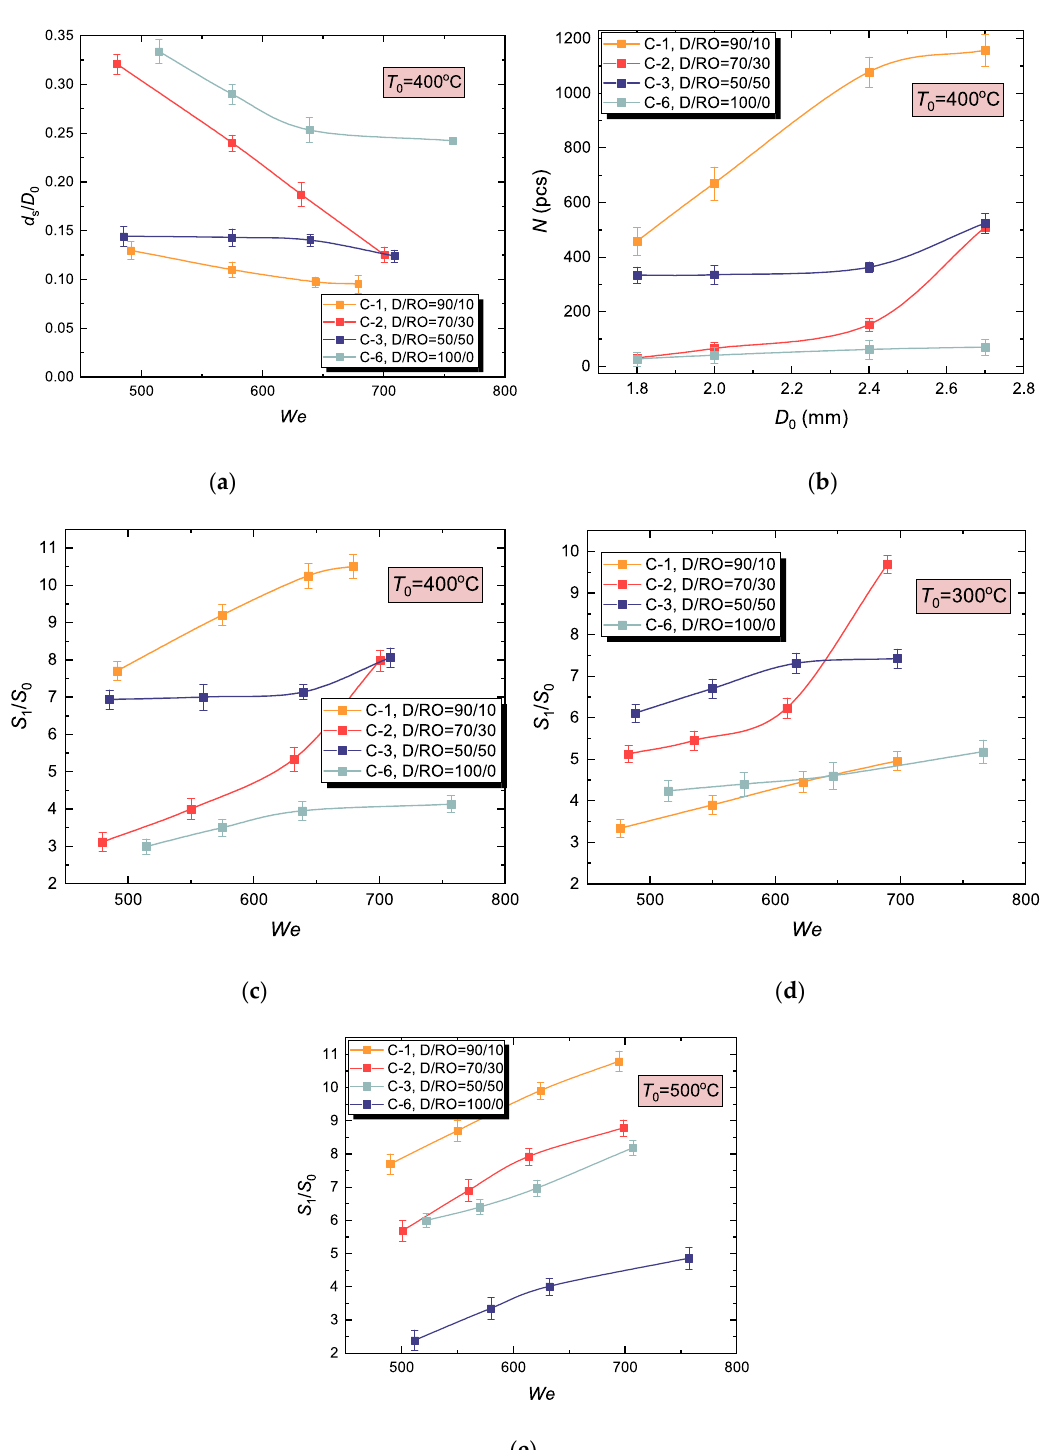
Figure 8. Effect of FAME of rapeseed oil (RO) added to the hydrocarbon component of micro-emulsion in different volume fractions on ( a ) mean diameter of child droplets generated by hydrodynamic breakup, ( b ) their amount, and ( c – e ) fuel evaporation surface area; ( a – c ) T 0 = 400 °C, ( d ) T 0 = 300 °C, ( e ) T 0 = 500 °C.